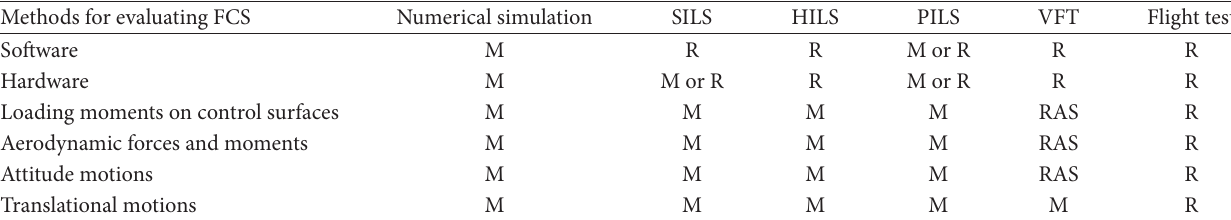
Table 2: Comparisons between VFT and traditional evaluation